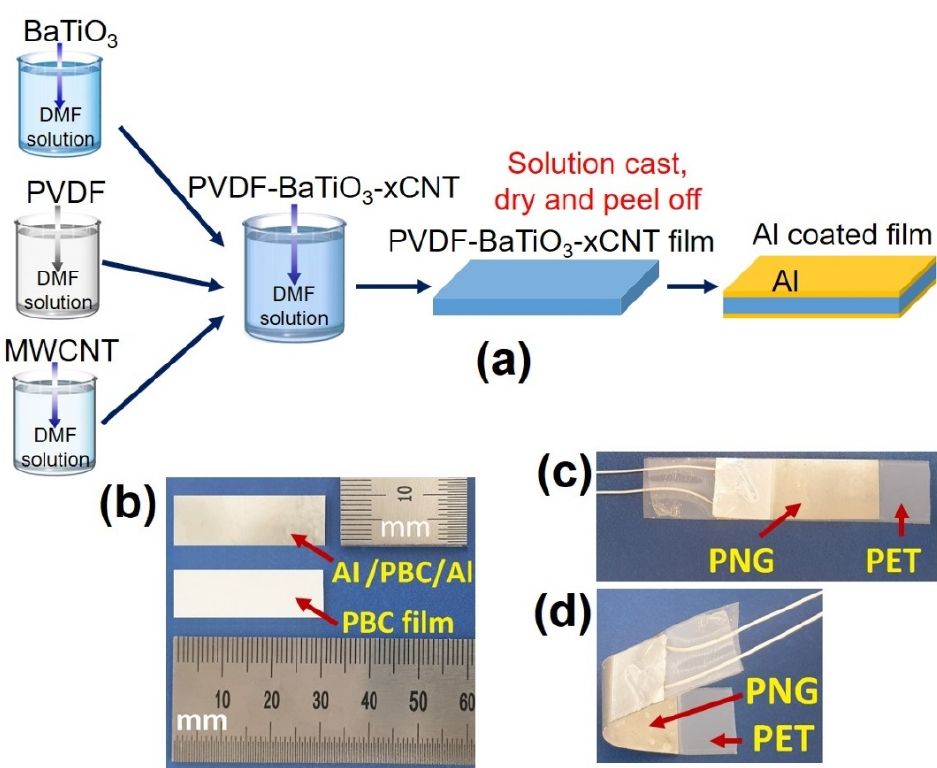
Figure 1. ( a ) Process flow and schematic view of the PVDF–BaTiO 3 -xCNT (PBC) film and piezoelectric nanogenerator (PNG); ( b ) photograph of the as-prepared PBC film without and with Al coating. Film dimension is 3 × 1 cm square; ( c ) photograph of PNG after packaging with PET film; ( d ) photograph of the PNG device with good flexibility.